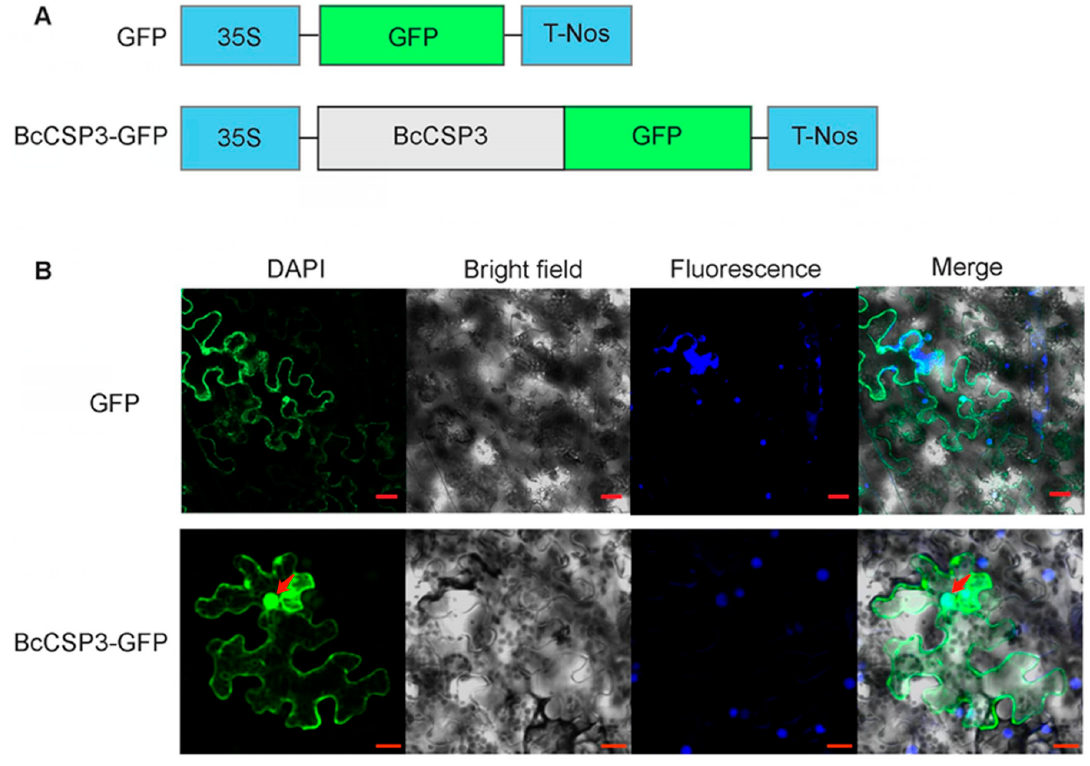
Figure 8. Subcellular localization of BcCSP3. ( A ) Constructs used in the experiments; ( B ) BcCSP3–GFP was transferred to tobacco leaf cells to test and verify the subcellular localization of BcCSP3 (bar = 20 μ m).